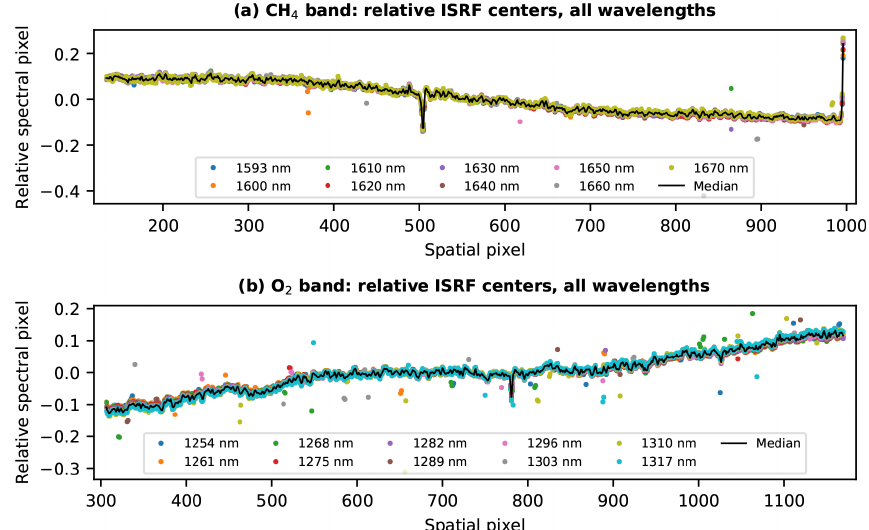
Figure 15. For each wavelength, the spectral pixel center at every spatial pixel is shifted to align all wavelengths for a given band. The median of the combined data is taken (black line), resulting in a smoothed version of the central spectral pixel indices for all spatial pixels. Variations common to all wavelengths, such as the feature near spatial pixel 505 in the CH 4 band (a) , are preserved in the smoothing. These are real features, likely due to irregularities in the slit